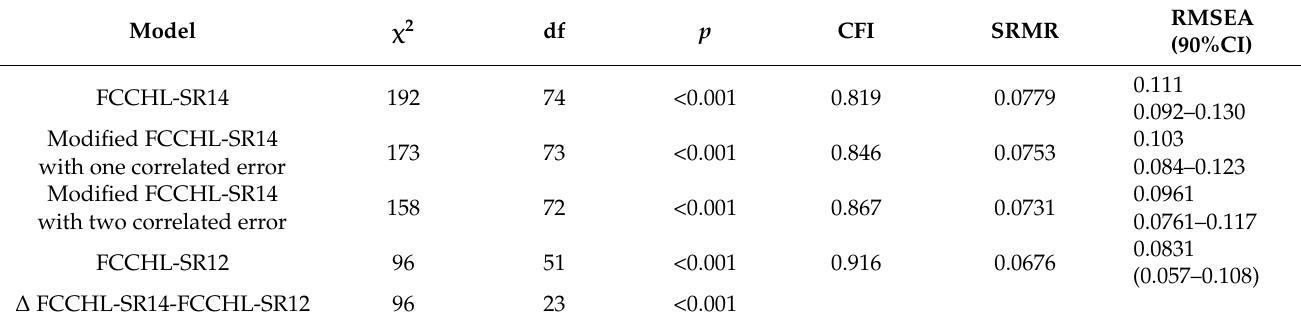
Table 5. Models fit coefficients.